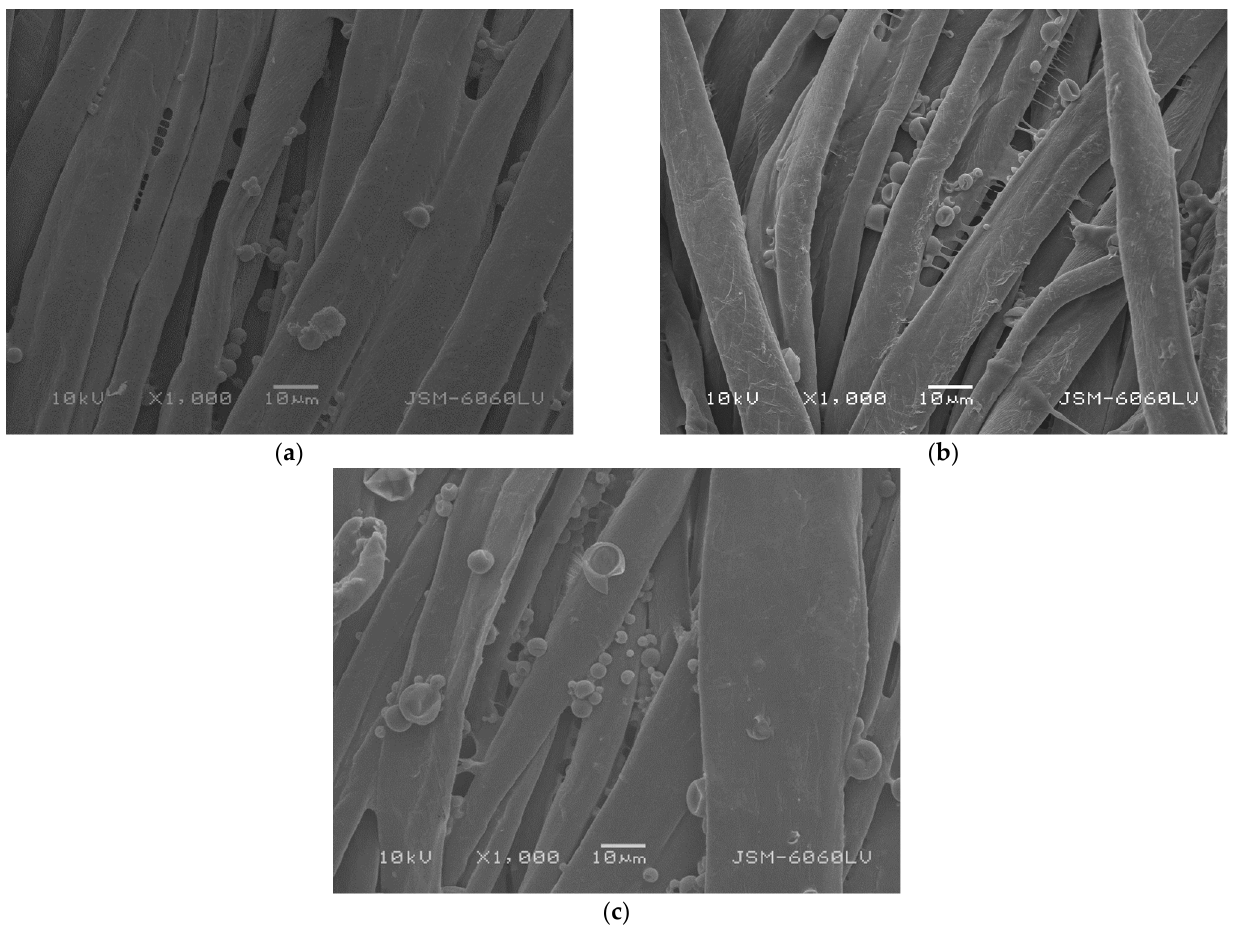
Figure 4. SEM images of ( a ) untreated, ( b ) O 2 plasma-treated, and ( c ) N 2 plasma-treated samples of cotton fabric impregnated with fragrance microcapsules.